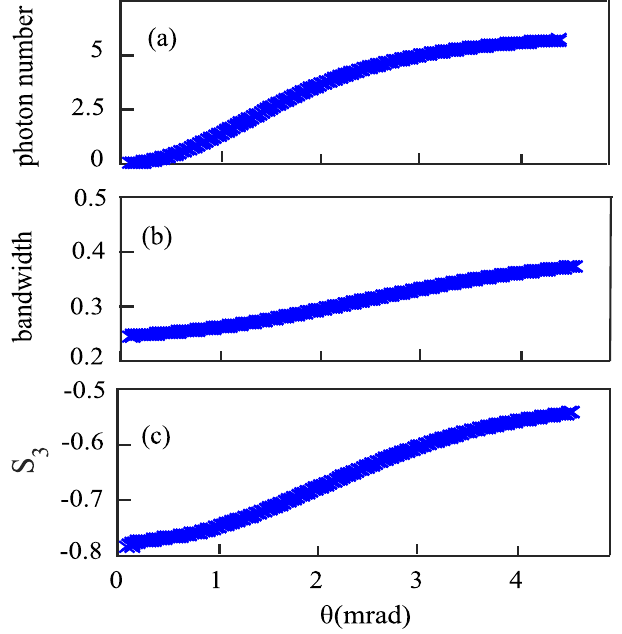
10. (a) Photon flux, (b) bandwidth, and (c) Stokes parameter S 3 vs acceptance angle for a typical plasma beam.